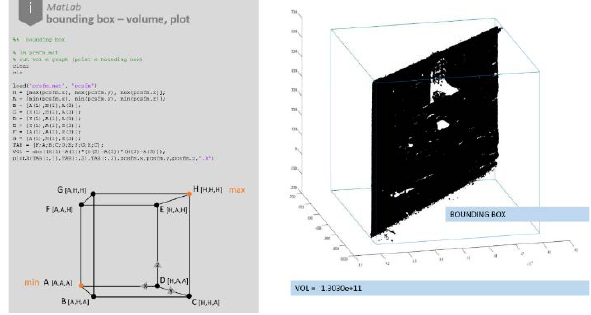
Figure 19. Calculation of volume of the bounding